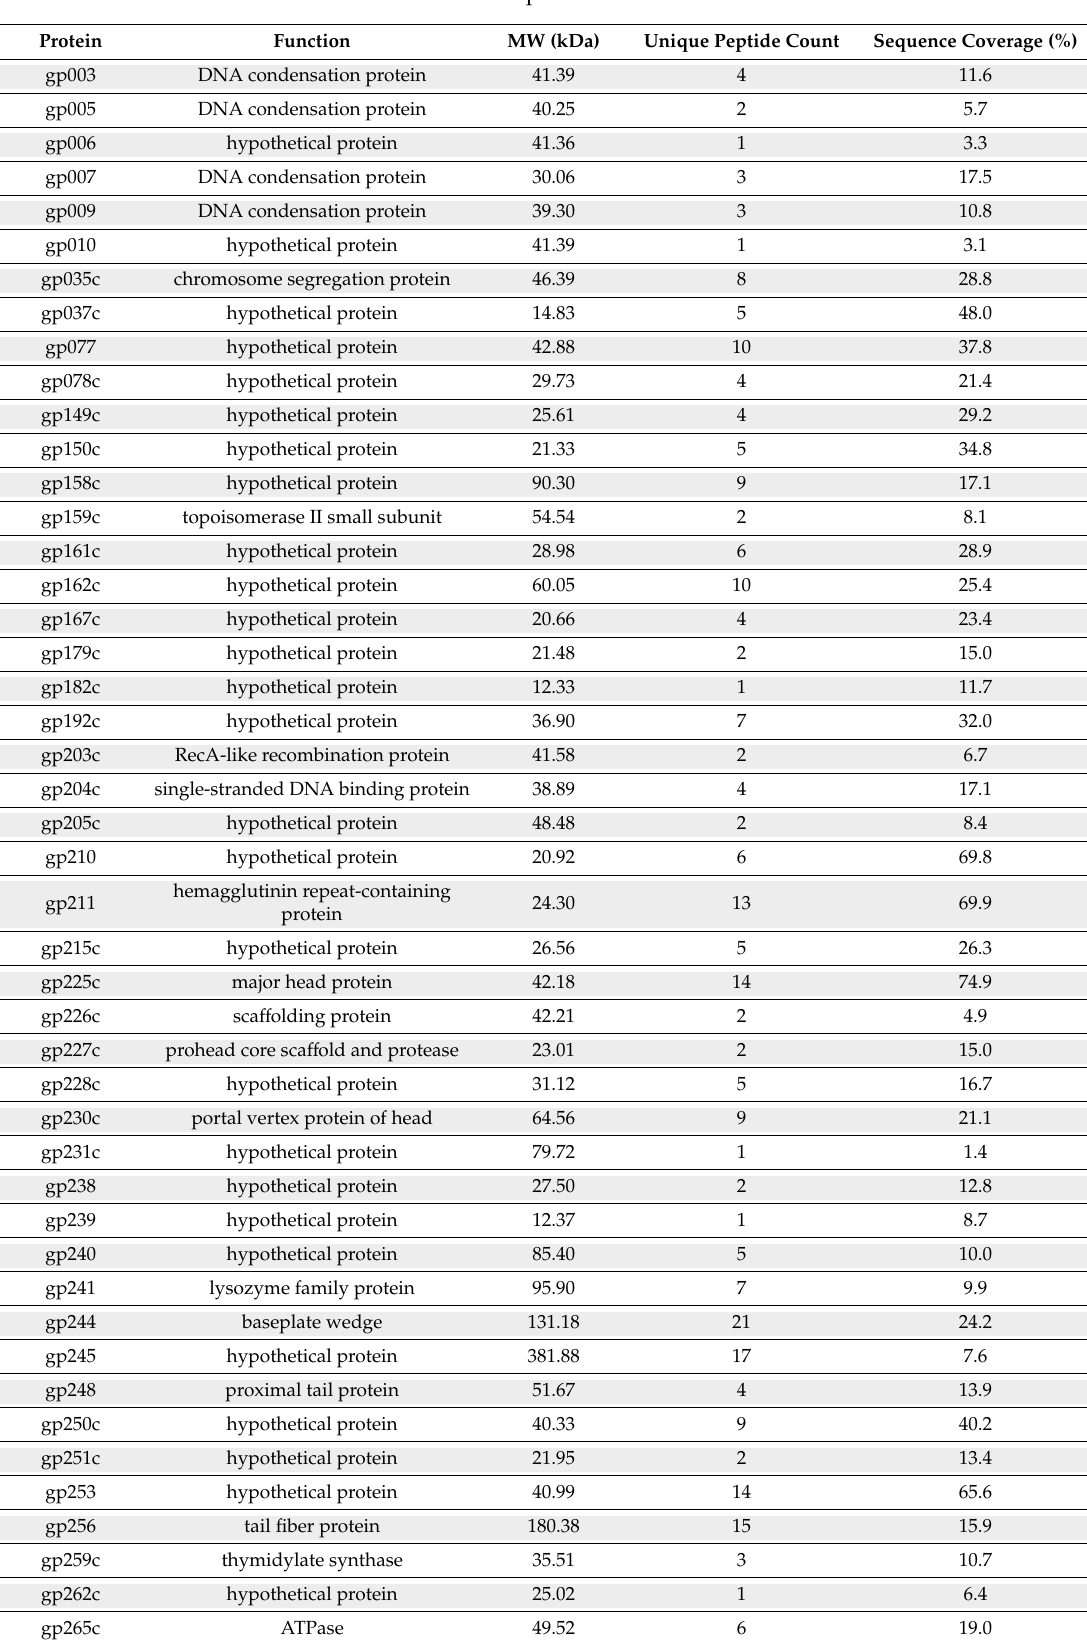
Table 1. Structural proteome of